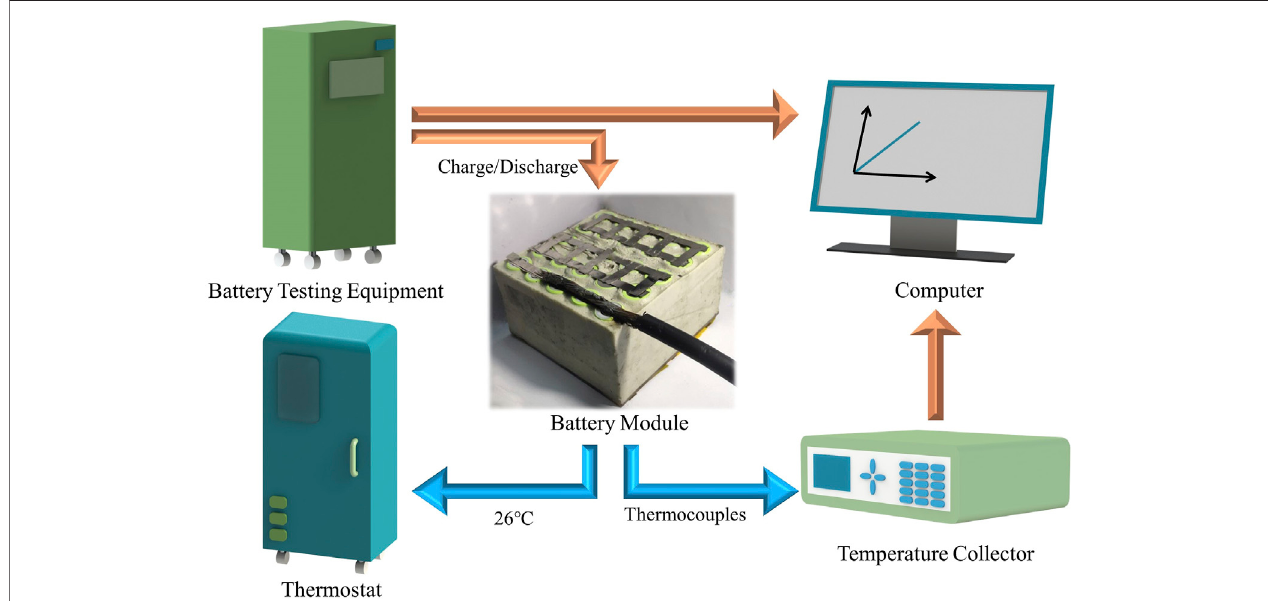
FIGURE 2 | Battery charging/discharging temperature measurement system.